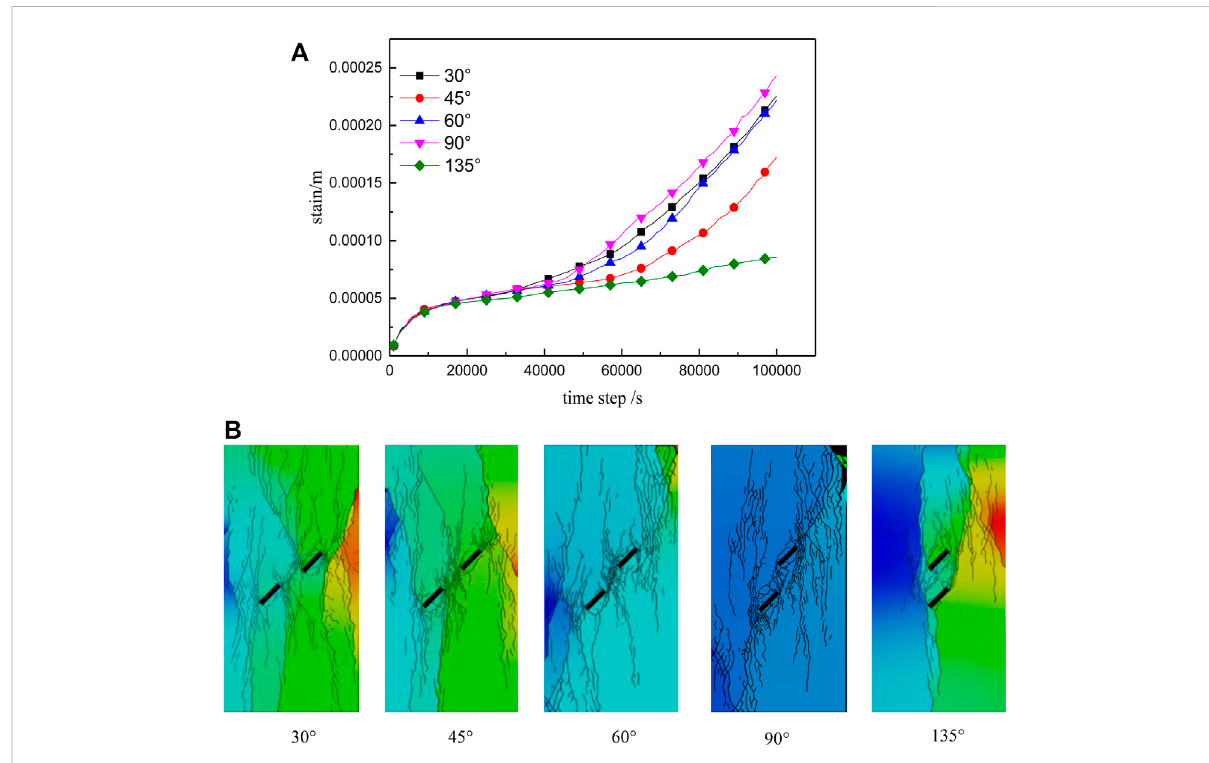
FIGURE 13 Creep curves (A) and rupture diagrams (B) for fractured rock masses with different rock bridge